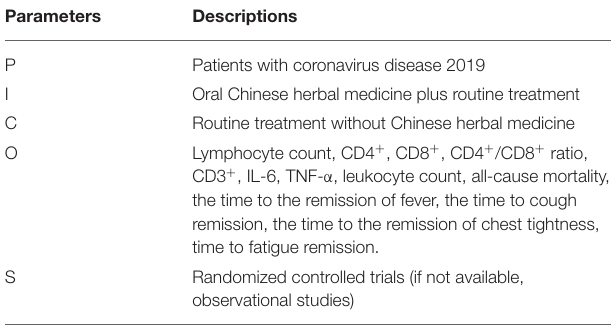
TABLE 1 | PICOS for study